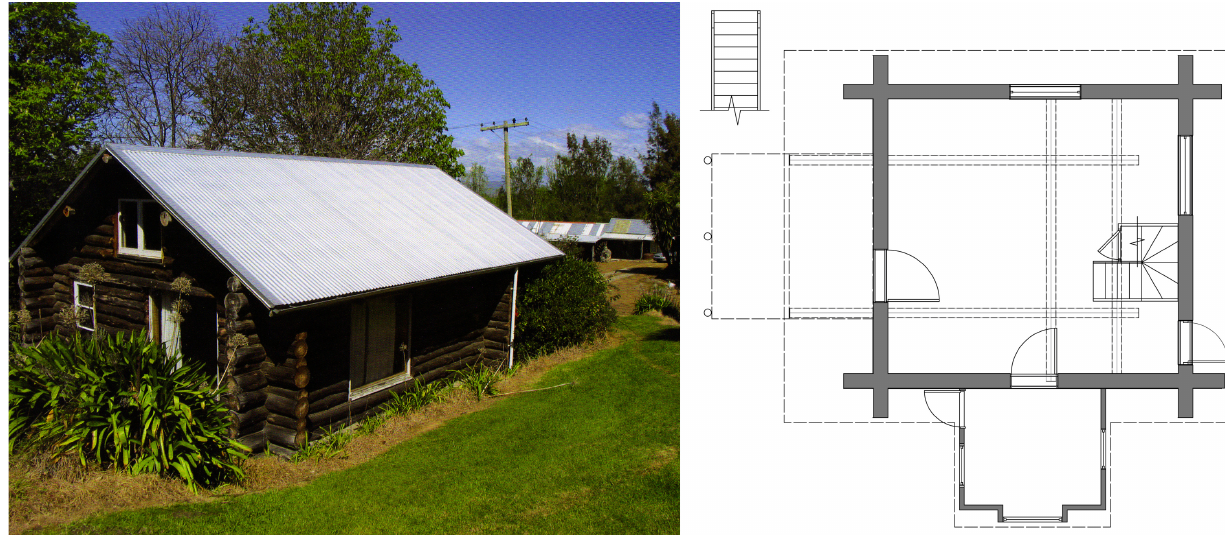
Figure 1. The LC before renovations: A view from the northwest (left) and the ground floor plan (right). (Schön, 1987; Smith et al., 2009). In addition to dis‐ cussions focusing on the need for pro‐environmental attitudes to manifest the context of sustainability and ecology through design, the students were asked to be mindful of the particular history of the place and site,